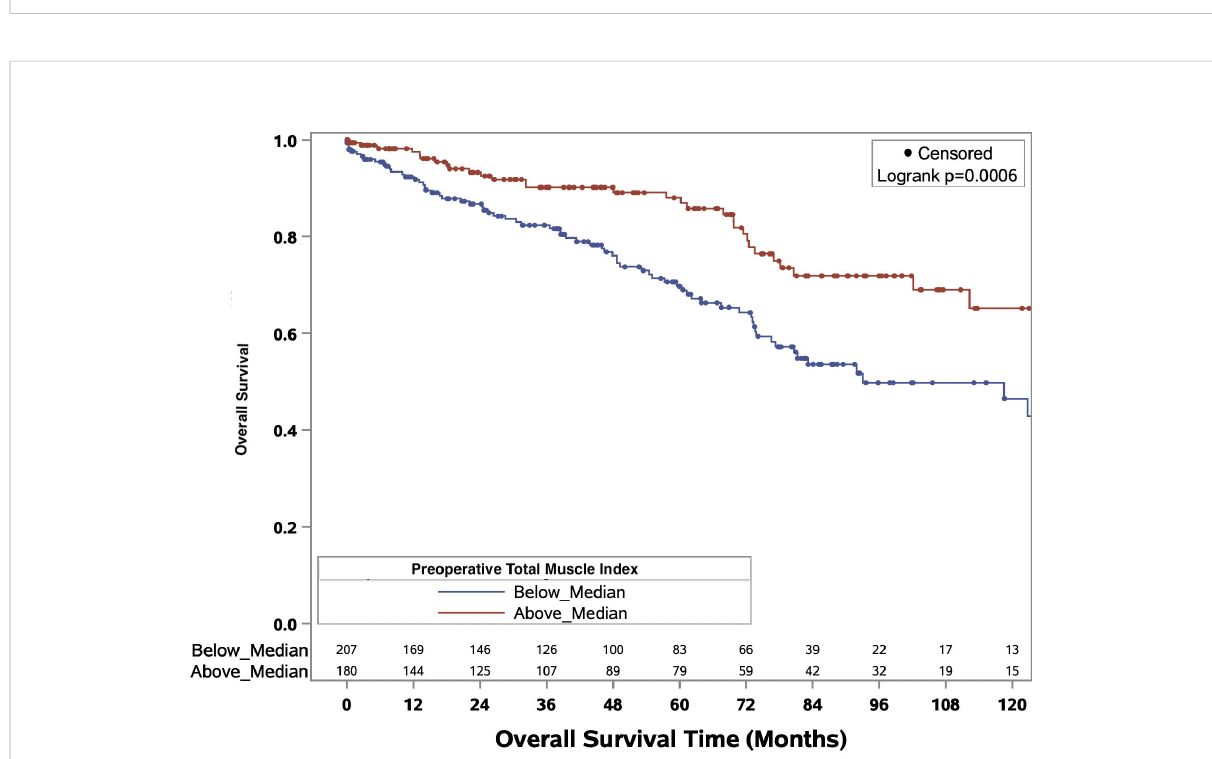
FIGURE 4 Kaplan-Meier curves evaluating median overall survival times in patients above or below median preoperative total muscle index for patients with clear cell renal cell